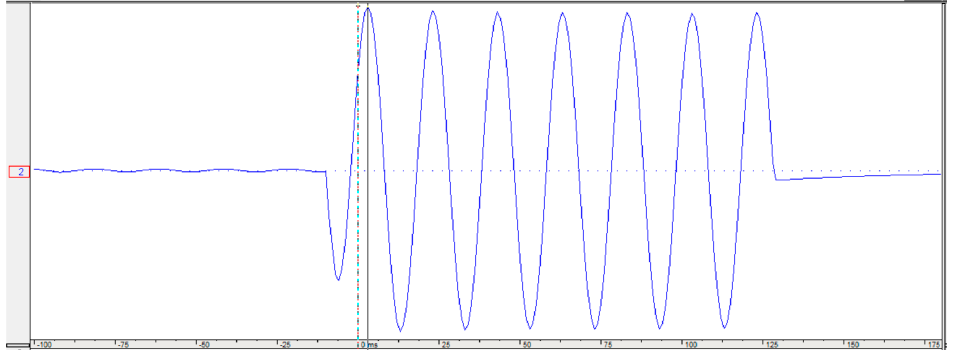
Figure 12. Behavior of a recorded fault current.